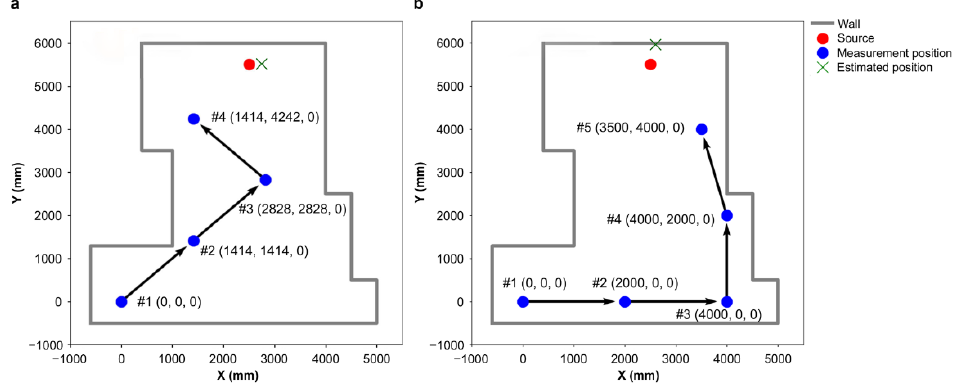
Figure 5. Search area, measurement positions, and movement paths: ( a ) Path I and ( b ) Path II.